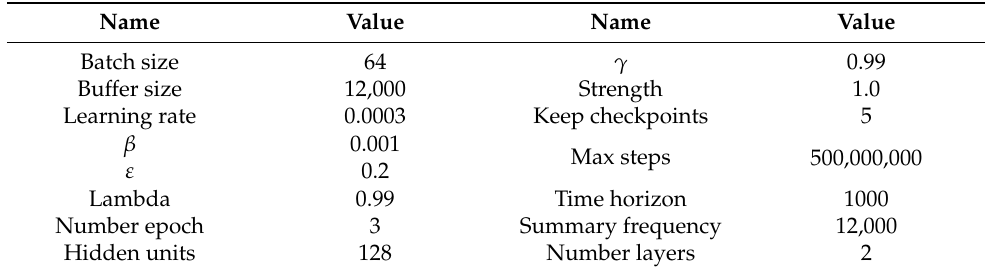
Table 1. Hyper-parameters and reward